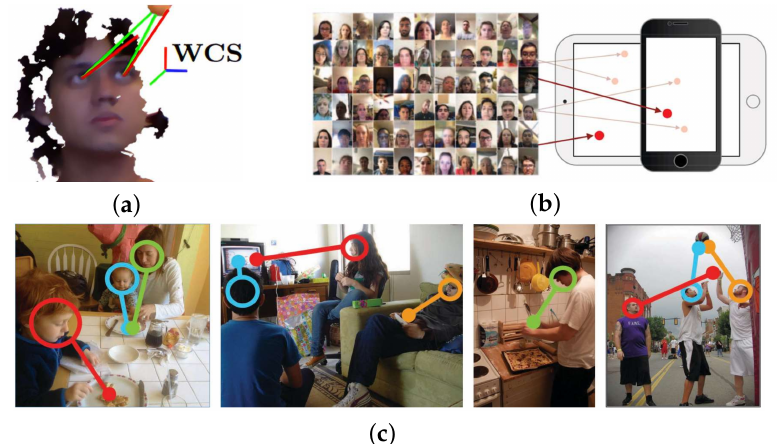
Figure 1. Examples of common tasks of gaze estimation: ( a ) three-dimensional (3D)-based estima- tion [9], ( b ) target estimation [10,11] and ( c ) tracking [12].